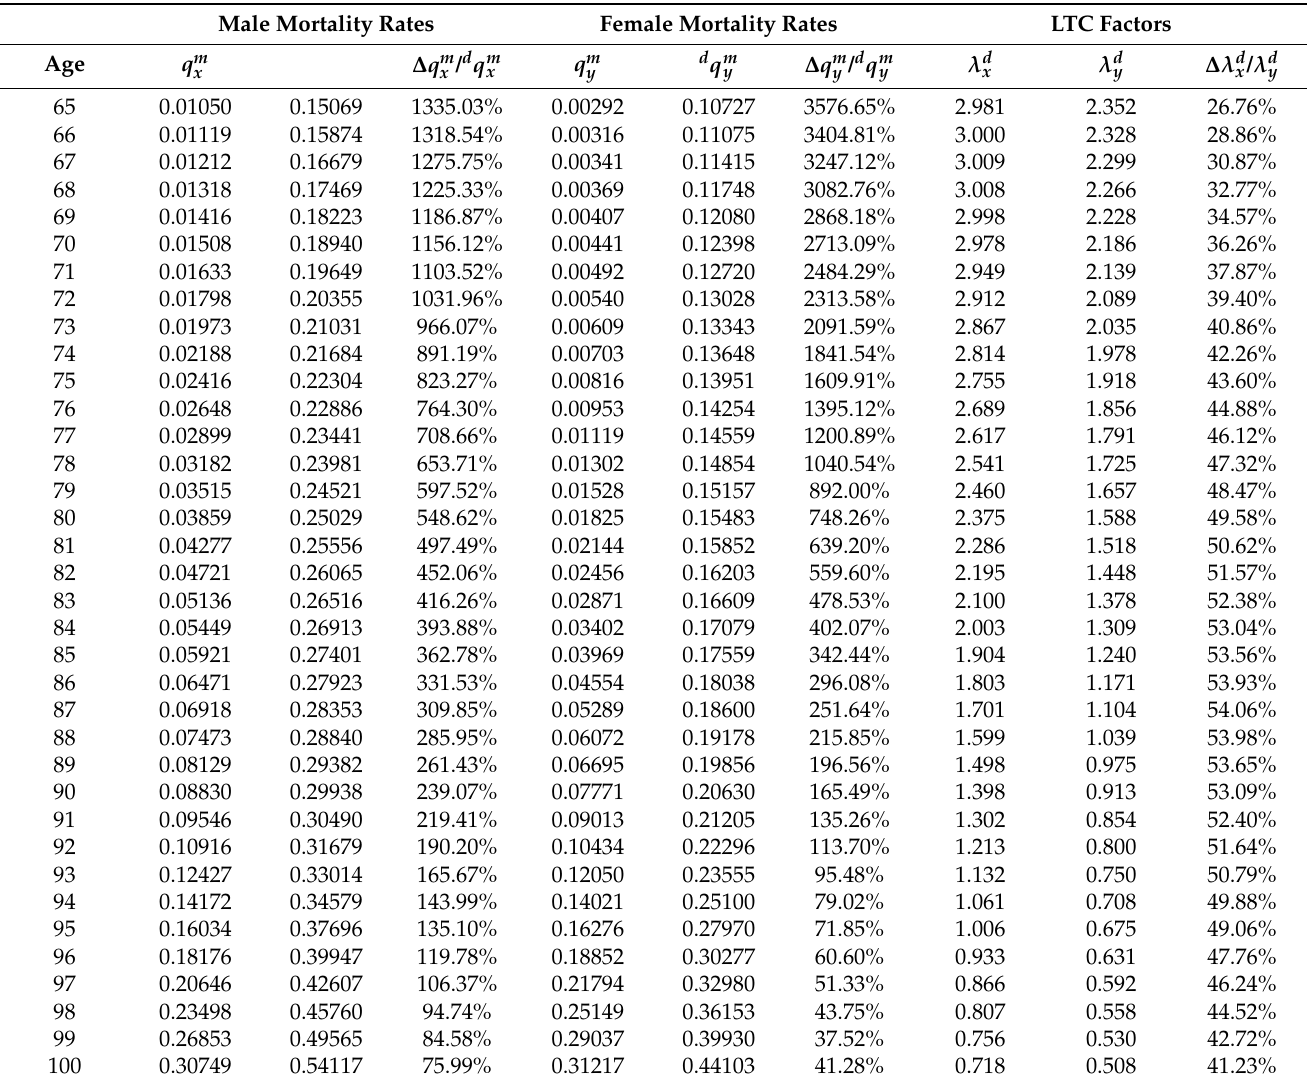
Table 2. Retirement outcomes for the 1960s generation. Source: Own work. Software used: